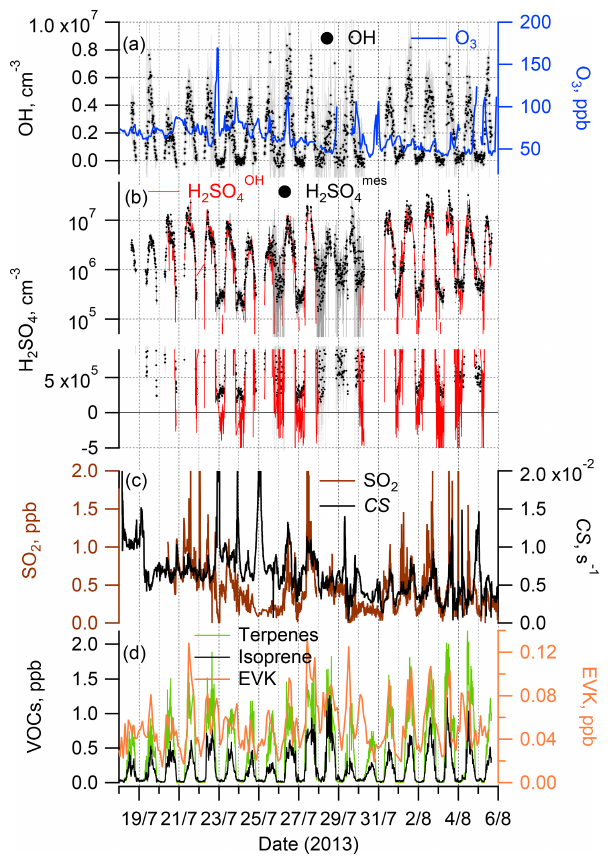
Figure 1. Time series of the observations during the ChArMEx summer 2013 campaign: OH radicals and O 3 (a) ; sulfuric acid observed, H 2 SO mes , and calculated assuming only an SO 2 + OH 4 source, H 2 SO OH (see Sect. 2.3) (b) ; SO 2 and condensation sink 4 (CS) (c) ; total monoterpenes and isoprene (left axis) and EVK (right axis) (d) . For clarity, a comparison of the measured H 2 SO mes calculated H 2 SO OH concentrations is presented in (b) using two 4 plots, with logarithmic and linear scales on the y